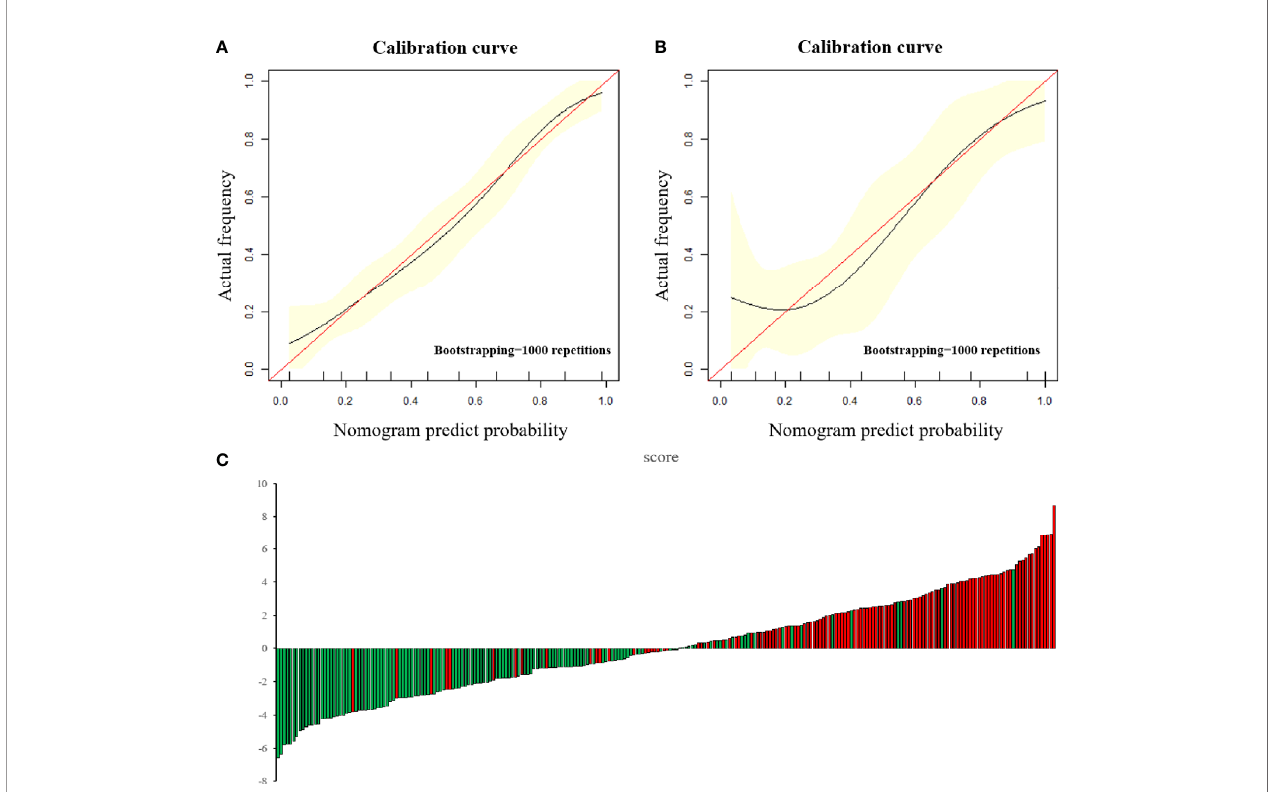
FIGURE 5 | (A , B) The calibration curve in the training cohort (A) and test cohort (B) . The calibration curve depicted the agreement between the predicted risk classi fi cation score and the actual results con fi rmed by con fi rmed by examination. The red line represents an ideal prediction, and the black line represents the predictive performance. The closer the fi t of the black line to the ideal line, the better the prediction. (C) Patient risk classi fi cation score output, while green bars show scores for those who were in low-risk group and red bars show that in high-risk